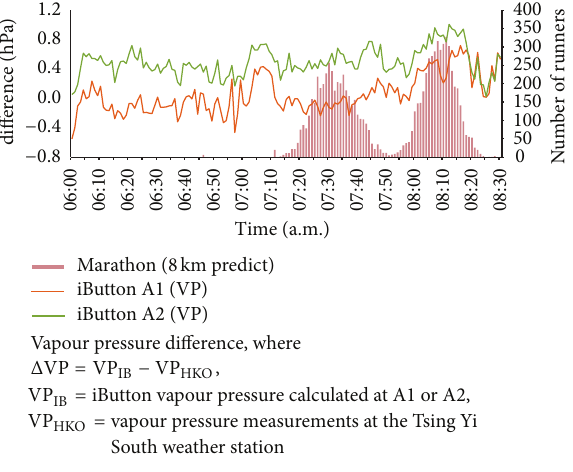
Figure 6: Minute-by-minute temperature difference and runner counts at the Cheung Tsing Tunnel (Site B: semienclosed